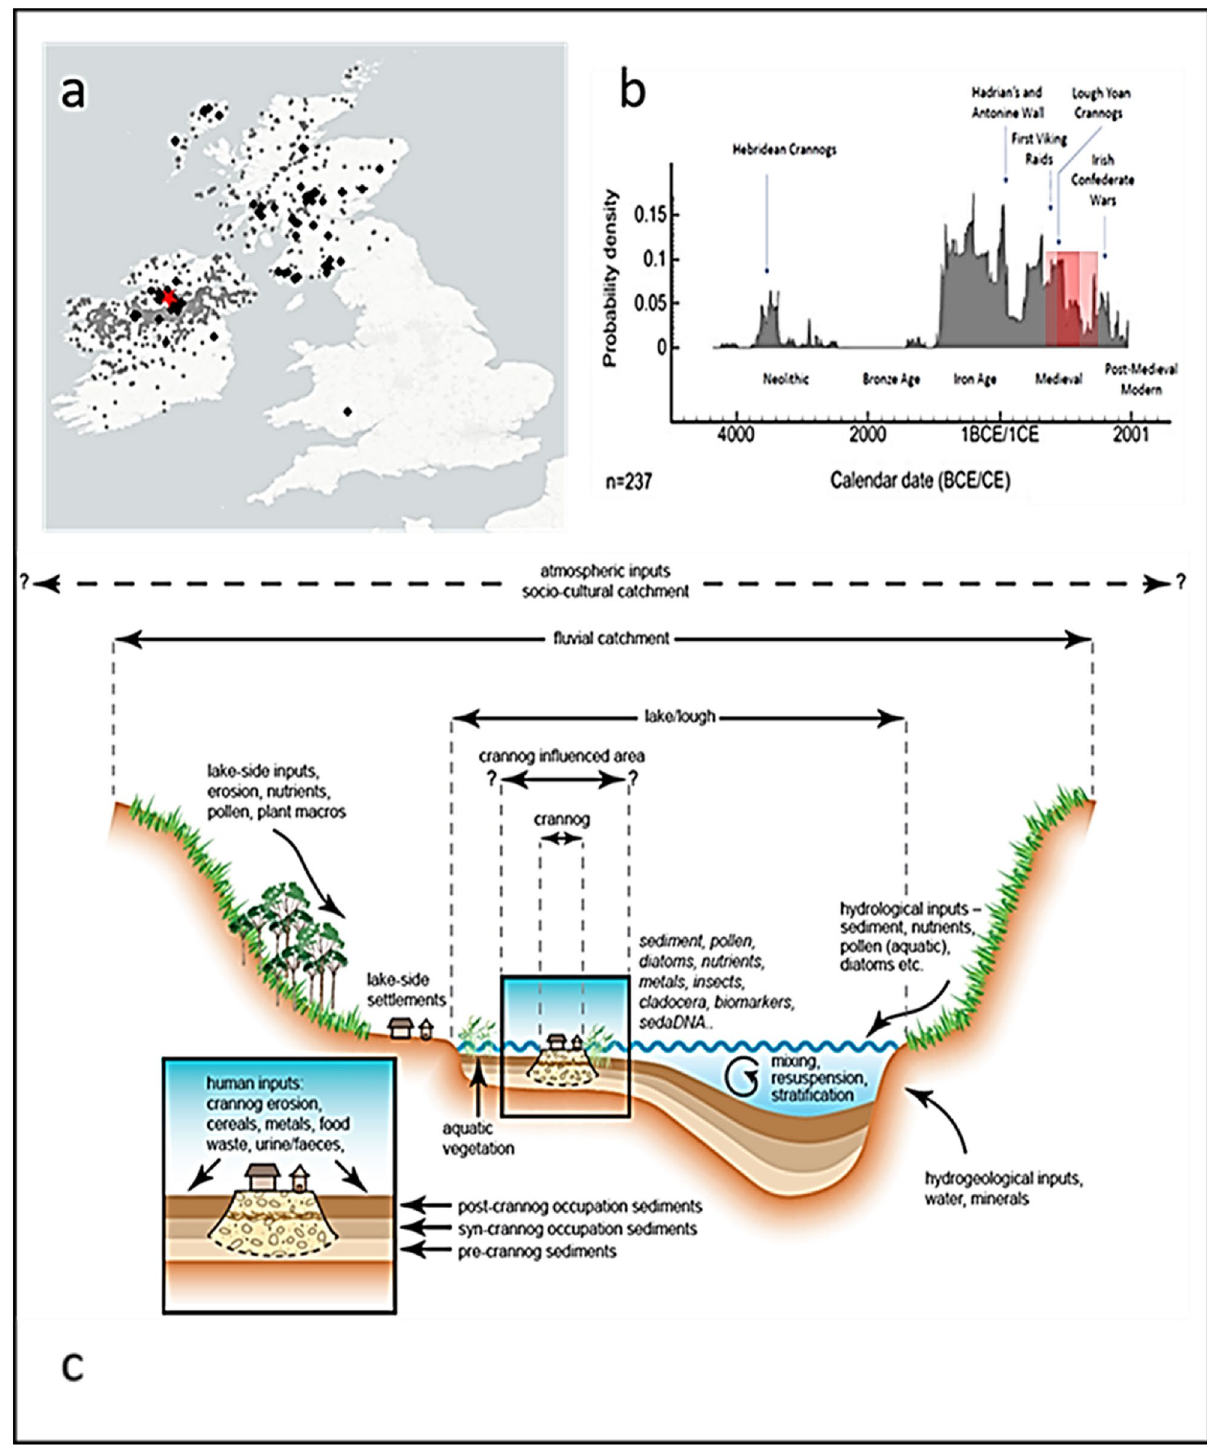
Figure 1. (a) The distribution of all crannogs in Celtic Britain and Ireland (grey circles), and crannogs with radiocarbon dates (black diamonds) collated as part of this study. The red star indicates the location of the study site, (b) age distribution of all dated crannogs based on the summed probability distribution of calibrated 14 C dates, with the red box covering the period of activity at Lough Yoan, and (c) typical environmental context and catchment areas for different proxies around a crannog-like lake